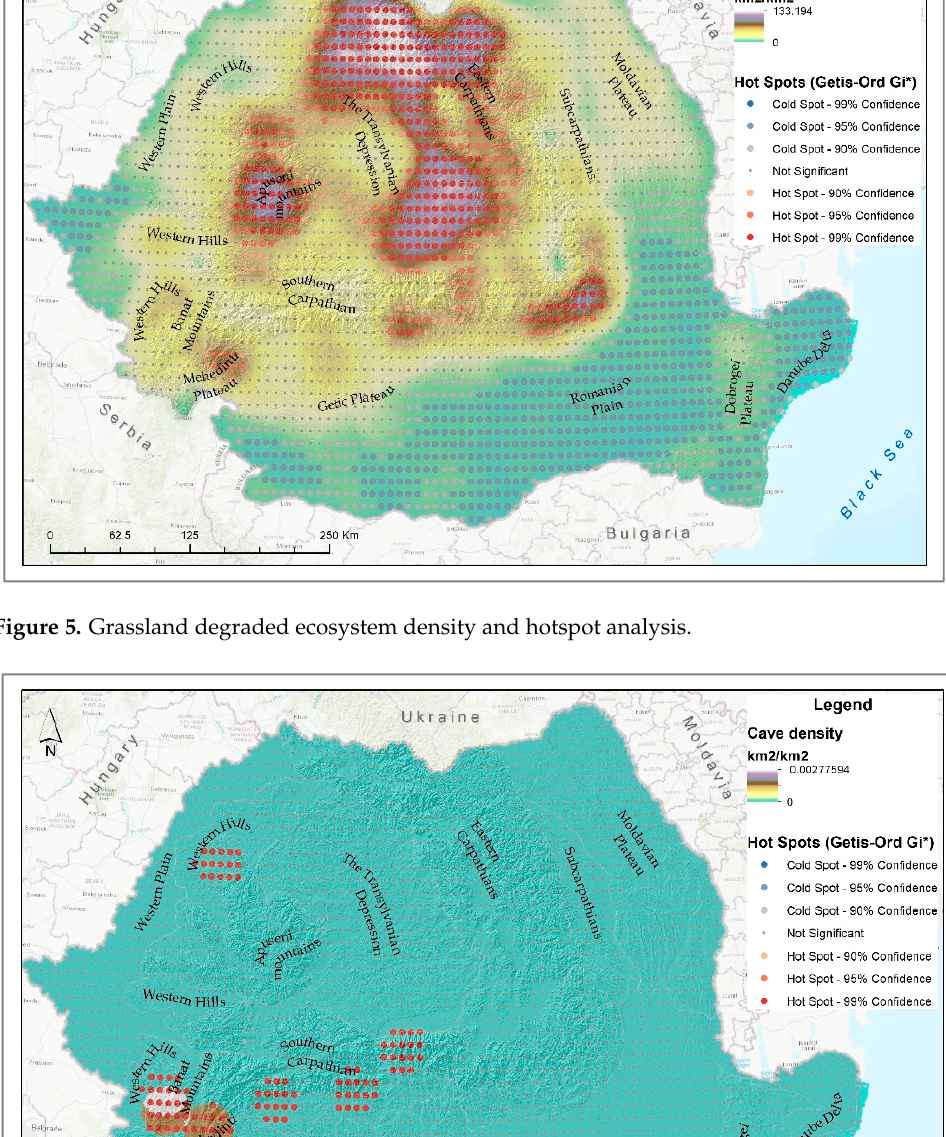
Figure 4. Forest degraded ecosystem density and hotspot analysis.